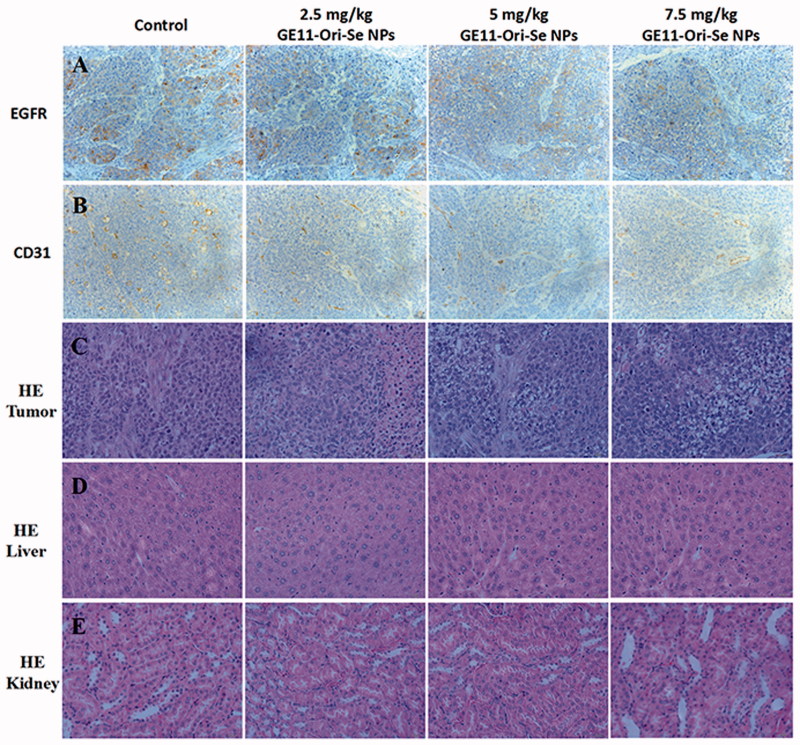
Immunohistochemical analysis of tumor, liver, and kidney from GE11-Ori-Se NPs treated mice. Immunohistochemical analysis of tumor sections from GE11-Ori-Se NPs treated mice by (A) EGFR staining, (B) CD31 staining, and (C) HE staining. HE staining analysis of (D) liver and (E) kidney from GE11-Ori-Se NPs treated mice.